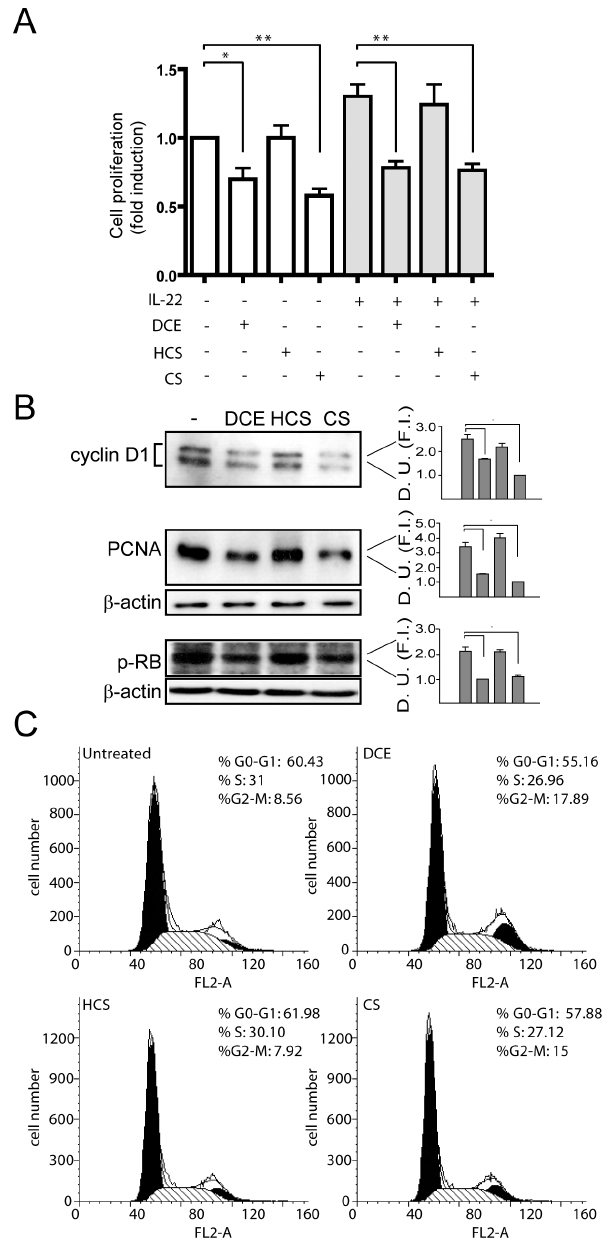
Figure 4. Inhibition of proliferation and cell-cycle progression of keratinocytes by DCE and CS. Proliferation of keratinocytes treated with DCE, CS or HCS either in presence or absence of IL-22 was proportional to crystal violet incorporation (A), which was measured with an ELISA reader after 2 d of culture. Data are expressed as fold induction of treated vs. untreated samples, which were given a value of 1. * p # 0.01 and ** p # 0.05. B) PCNA, cyclin D1, and pRB were analyzed by Western blotting. Graphs show densitometric values of PCNA, cyclin D1, and pRB staining on blots (D. U., Densitometric Units; F. I., Fold Induction). Western blots are representative of 3 independent experiments performed on 3 different keratinocyte strains obtained from biopsies of different healthy donors. * p # 0.01. C) Cell-cycle distribution analysis of cultured keratinocytes treated or not with DCE, CS, or HCS, for 16 h. The percentage of keratinocytes in G0-G1, S, and G2/M phases are indicated in each histograms.